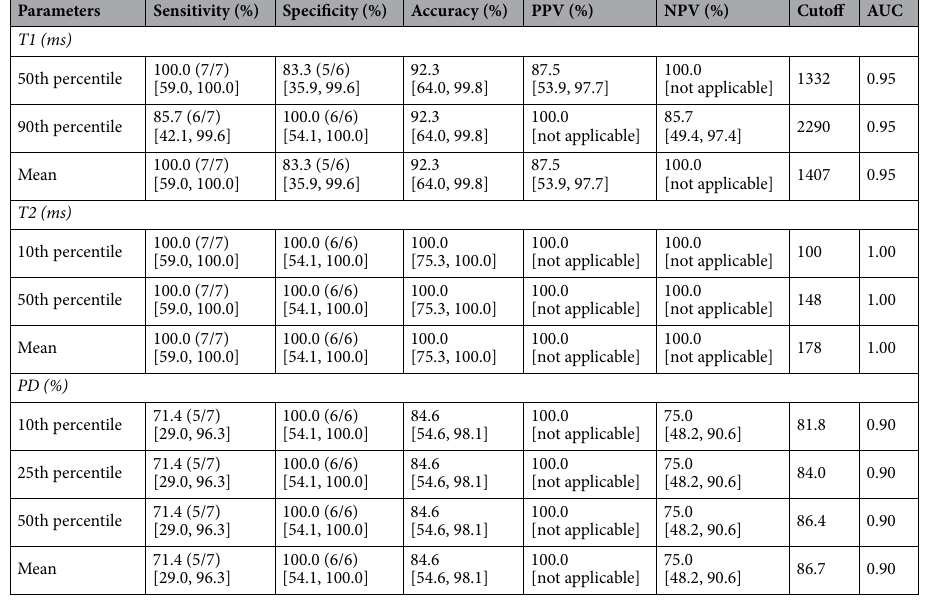
Table 3. Diagnostic performance of parameters in differentiating between IDH-mutant astrocytic tumors and IDH-mutant and 1p/19q-codeleted oligodendroglial tumors. AUC area under the curve, IDH isocitrate dehydrogenase, NPV negative predictive value, PD proton density, PPV positive predictive value. Data in parentheses are numerators/denominators; data in brackets are 95% confidence